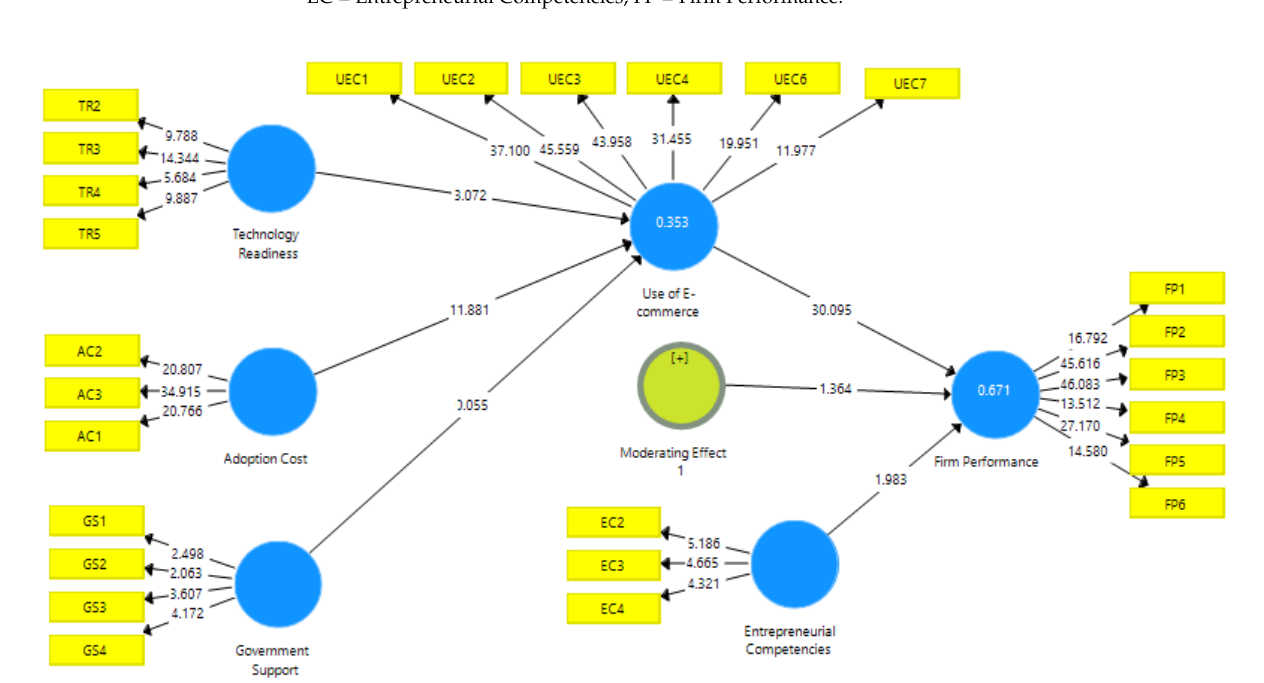
Figure 3. The structural model and moderating effect.